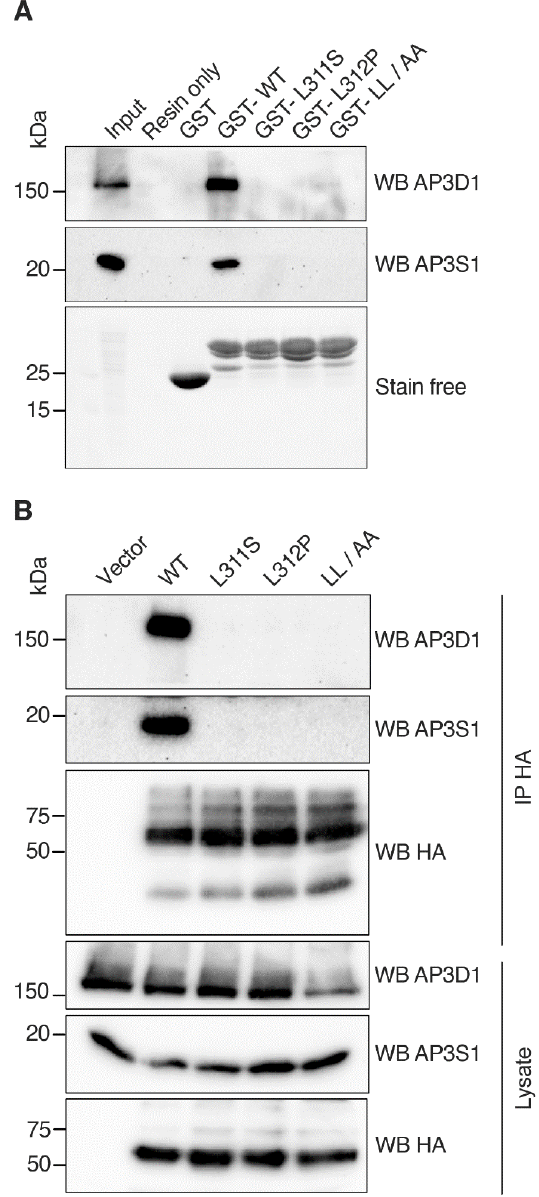
Figure 4. Alteration of the dileucine motif of RNF13 abrogates AP-3 complex binding. ( A ) GST pulldown was performed with HEK293T cell lysate incubated in the presence or absence of GST or purified GST-RNF13 (aa 281-381; WT, L311S, L312P, or LL/AA) immobilized on glutathione- functionalized sepharose 4B affinity resin. Complex formation was performed overnight at 4 ◦ C, followed by washes and elution in 2 × Laemmli buffer. Proteins were separated on SDS–PAGE and transferred to a PVDF membrane which was immunoblotted using specific primary antibodies against AP3S1 and AP3D1. Representative immunoblots from three independent experiments (N = 3) are shown. ( B ) Plasmid constructs encoding HA-tagged WT, L311S, L312P, or L311L312/AA RNF13 were transiently expressed in HEK293T cells. Following lysis, cell lysates were incubated for 2 h at 4 ◦ C and then anti-HA immunoprecipitated complexes were washed and eluted in 2 × Laemmli buffer. Proteins were separated on SDS–PAGE and transferred to a PVDF membrane which was immunoblotted using specific primary antibodies against AP3S1, AP3D1, and HA (RNF13). Representative immunoblots from three independent experiments (N = 3) are